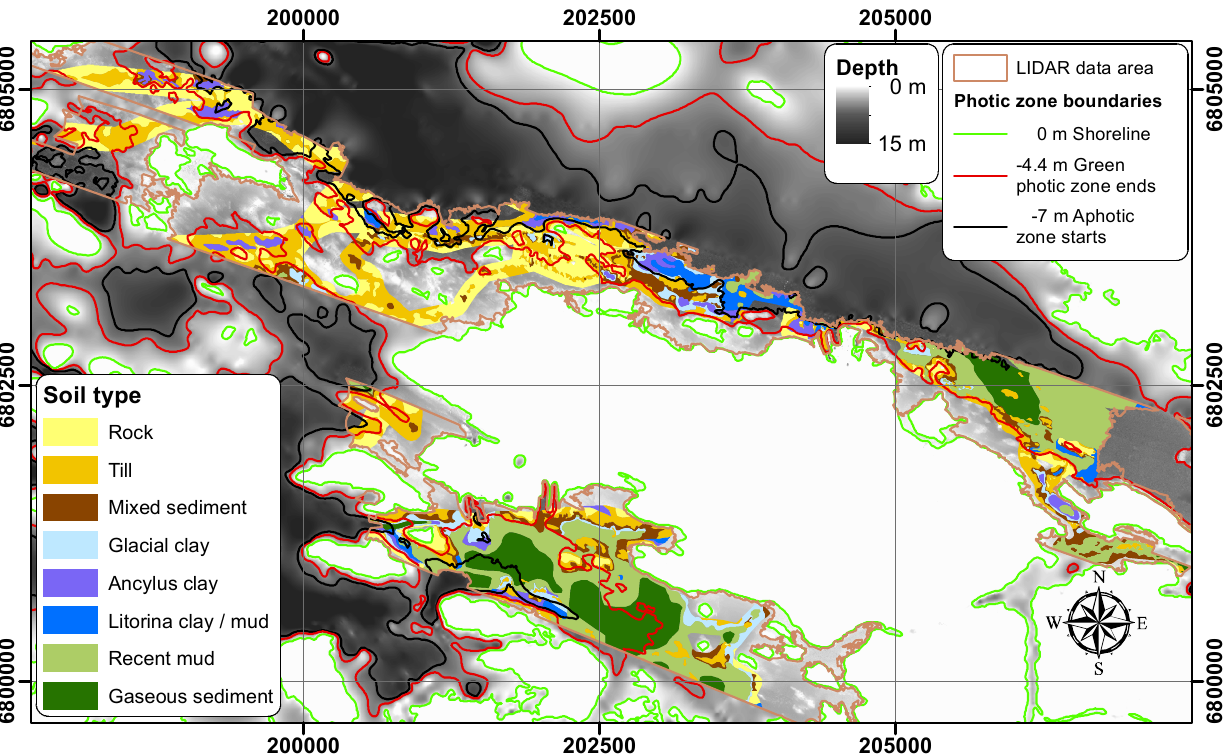
Figure 2. Reference map derived from the depth map and Geological Survey of Finland (GSF) survey data. The map is obtained by complementing the map of [12] (Appendix 3) with data along the survey lines in [11]. The map is recompiled by the authors using the ArcGIS software. The photic zones are also indicated on the map. (The data used in this figure was obtained from Posiva Oy with